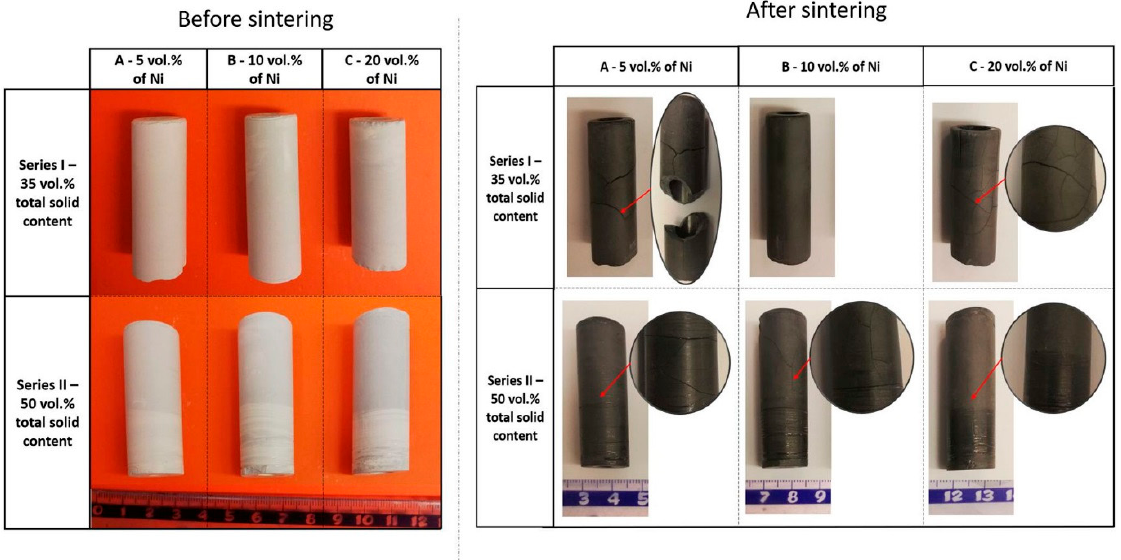
Figure 8. Photos of specimens before and after sintering.